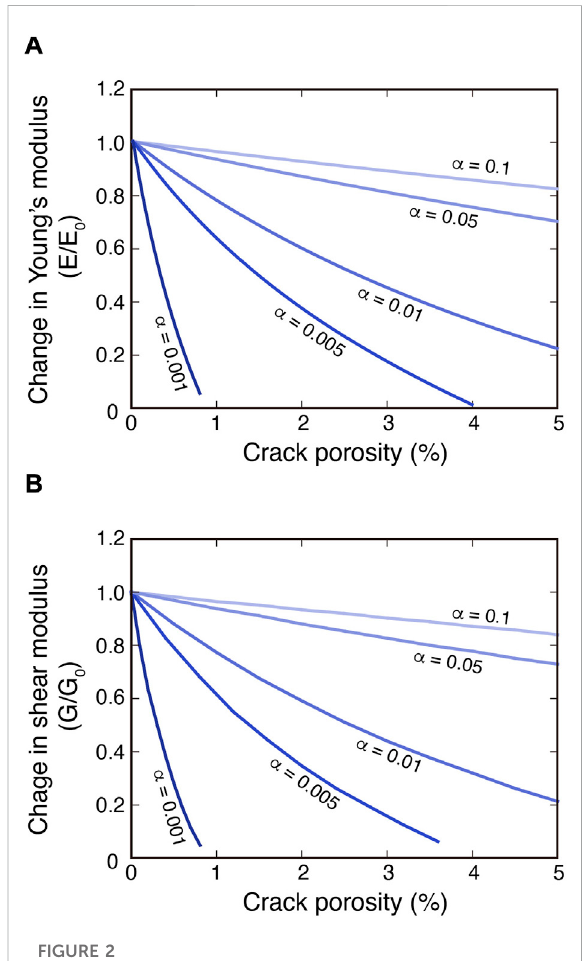
FIGURE 2 Effect of crack on elastic properties of rocks. Changes in Young ’ s modulus (A) and shear modulus (B) as a function of crack porosity (%) with different aspect ratio α , calculated from the effective medium theory of Kuster and Toksöz